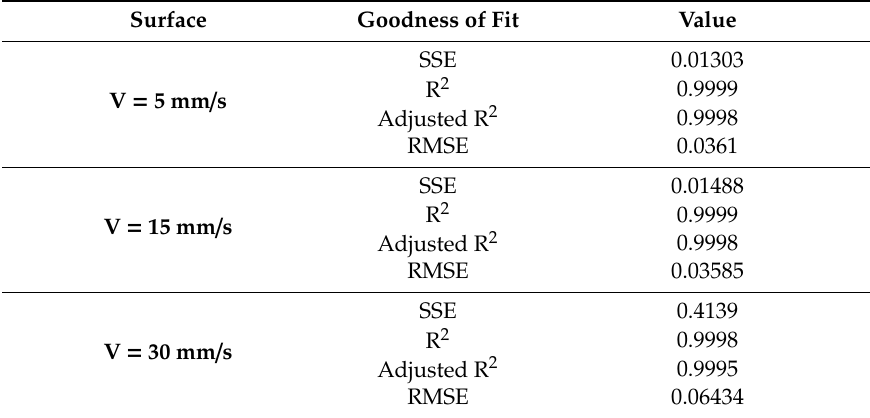
Table 6. Goodness of fit for each surface plot